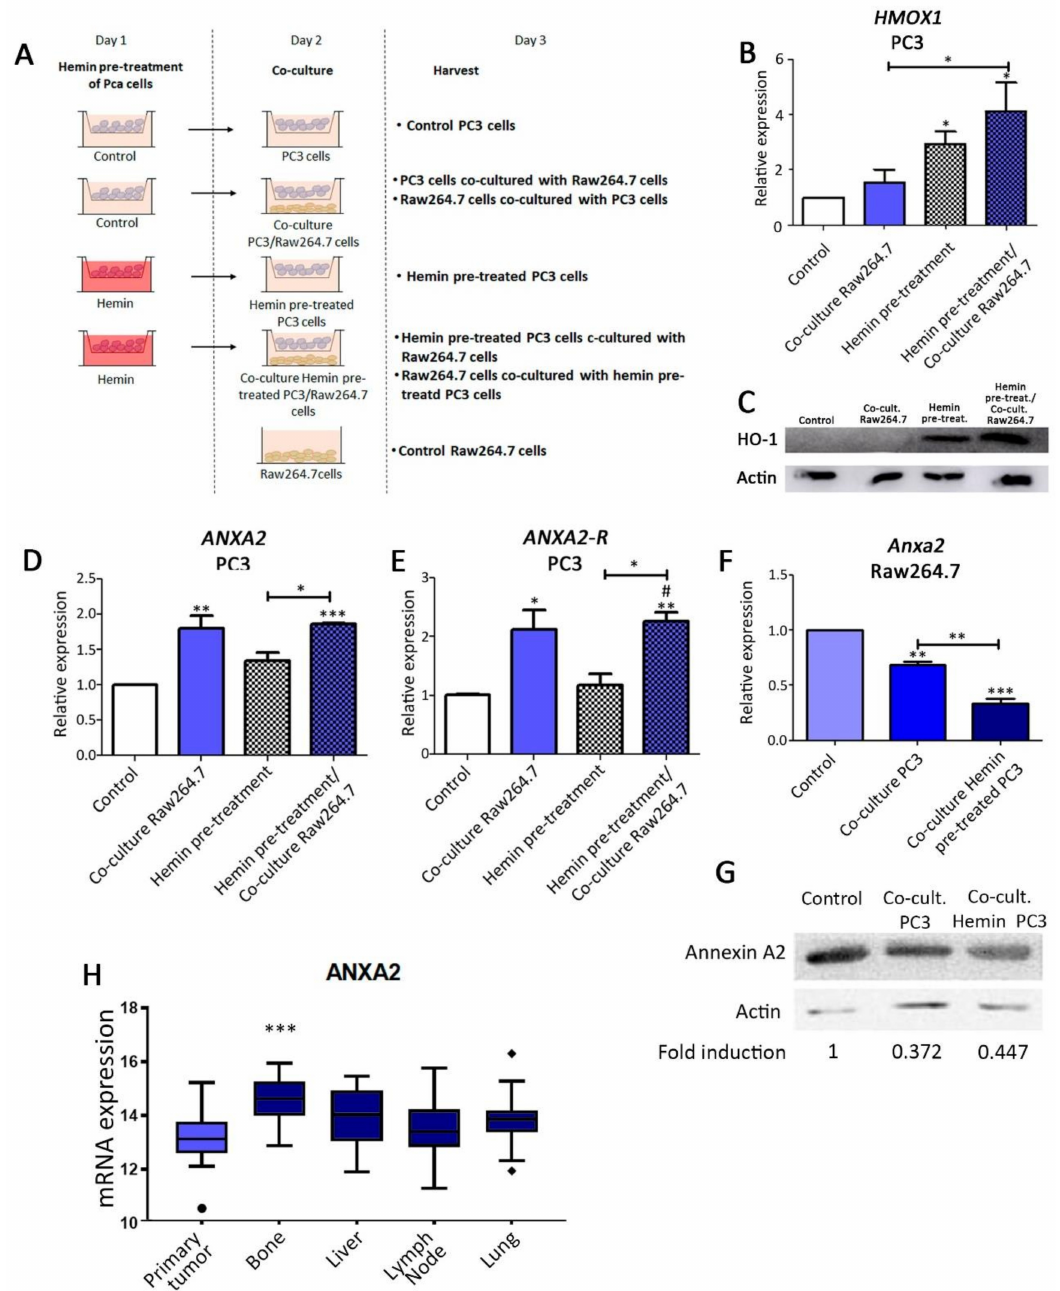
Figure 1. Analysis of annexin 2 ( ANXA2 ) expression in PC3 and bone progenitors’ cells grown in co-culture conditions. E ff ect of heme oxygenase 1 (HO-1) induction. ( A ) Schematic representation of the co-culture transwell system of PC3 and Raw264.7 cells. Expression levels of ( B , C ) HO-1 assessed by real-time PCR (RT-qPCR) and WB; ( D ) ANXA2 and ( E ) ANXA2-R assessed by RT-qPCR in PC3 cells pre-treated or not with hemin (50 µ M; 24 h), grown alone or in co-culture with Raw264.7 cells. The values were relativized using PPIA as a reference gene and normalized to controls. Expression levels of Anxa2 assessed by RT-qPCR ( F ) (relativized to 36b4 as a reference gene) or Western blot ( G ) (relativized to β -actin, as a reference protein), in Raw264.7 cells grown alone or in co-culture with PC3 cells pre-treated or not with hemin (50 µ M; 24 h). ( H ) Expression levels for ANXA2 in primary tumor vs. di ff erent sites of metastasis (bone, liver, lymph node, lung), analyzed on the GSE74685 dataset ( n = 171). Significant di ff erences: * p < 0.05; ** p < 0.01; *** p <